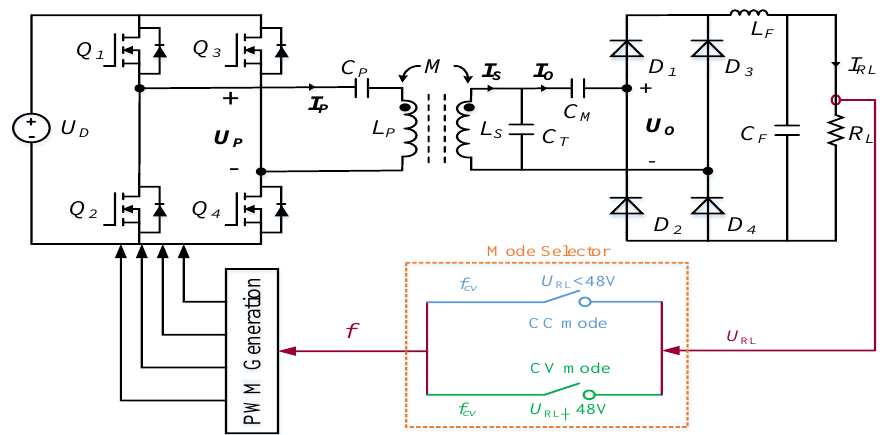
Figure 8. Switch strategy of the S/PS−compensated WPT system.